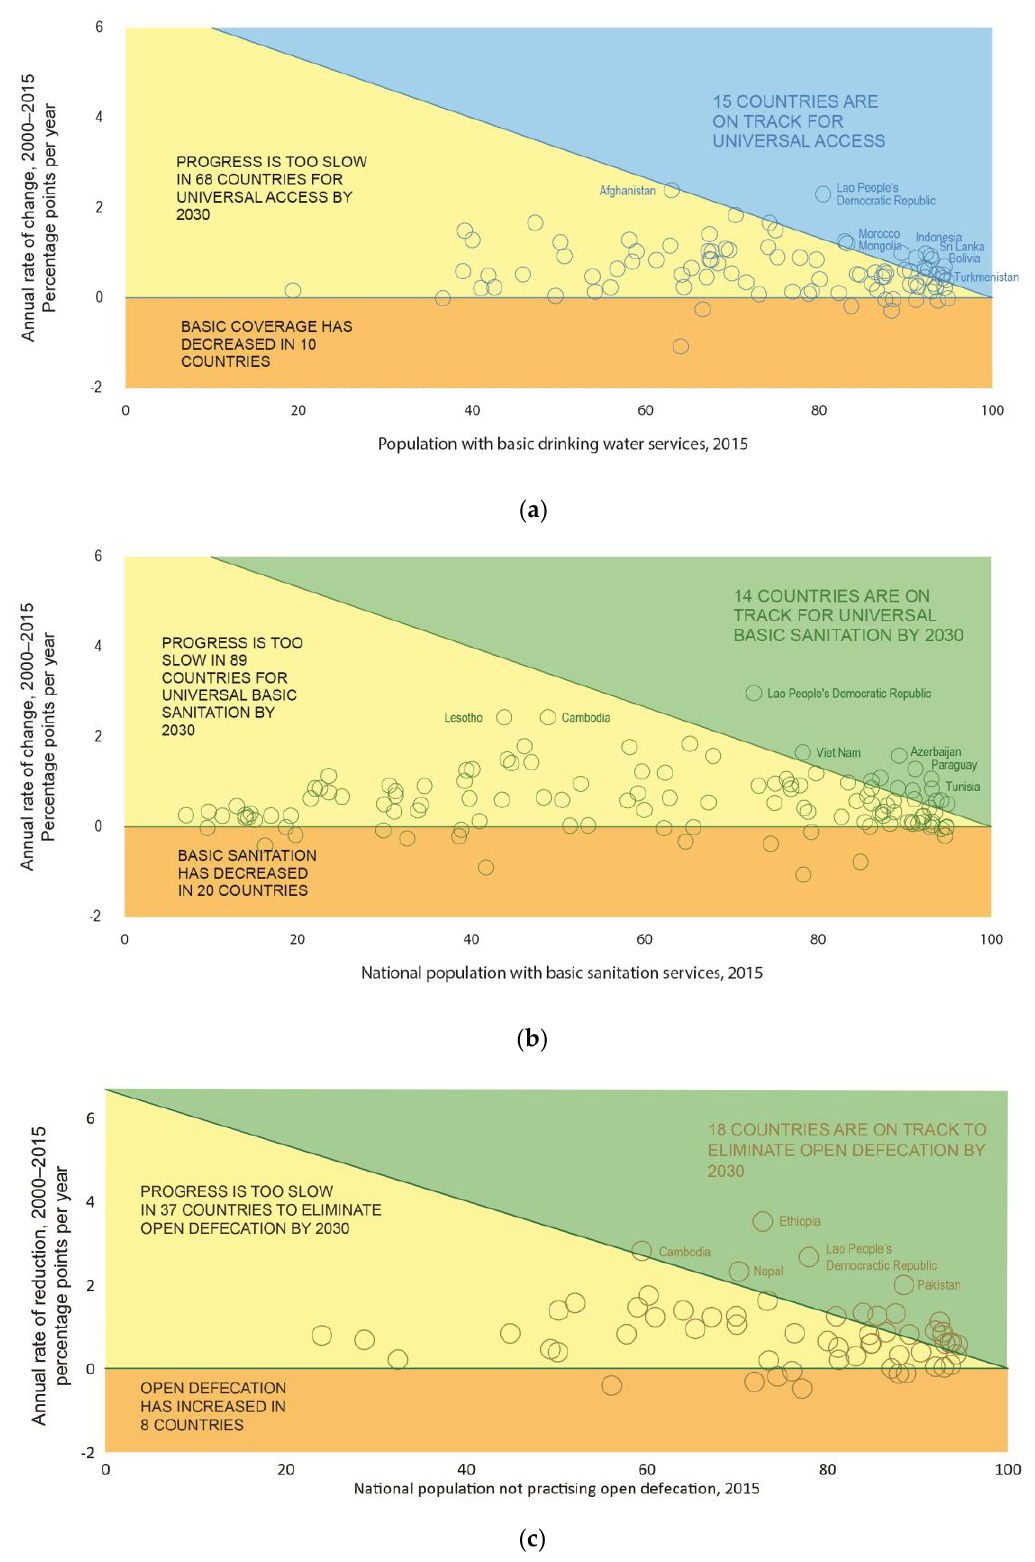
Figure 4. Progress towards universal ( a ) basic drinking water and ( b ) basic sanitation services and ( c ) elimination of open defecation by 2030. Charts show countries where at least 5% of the population lacked basic services or practised open defecation in 2015. Source: WHO/UNICEF JMP 2017.